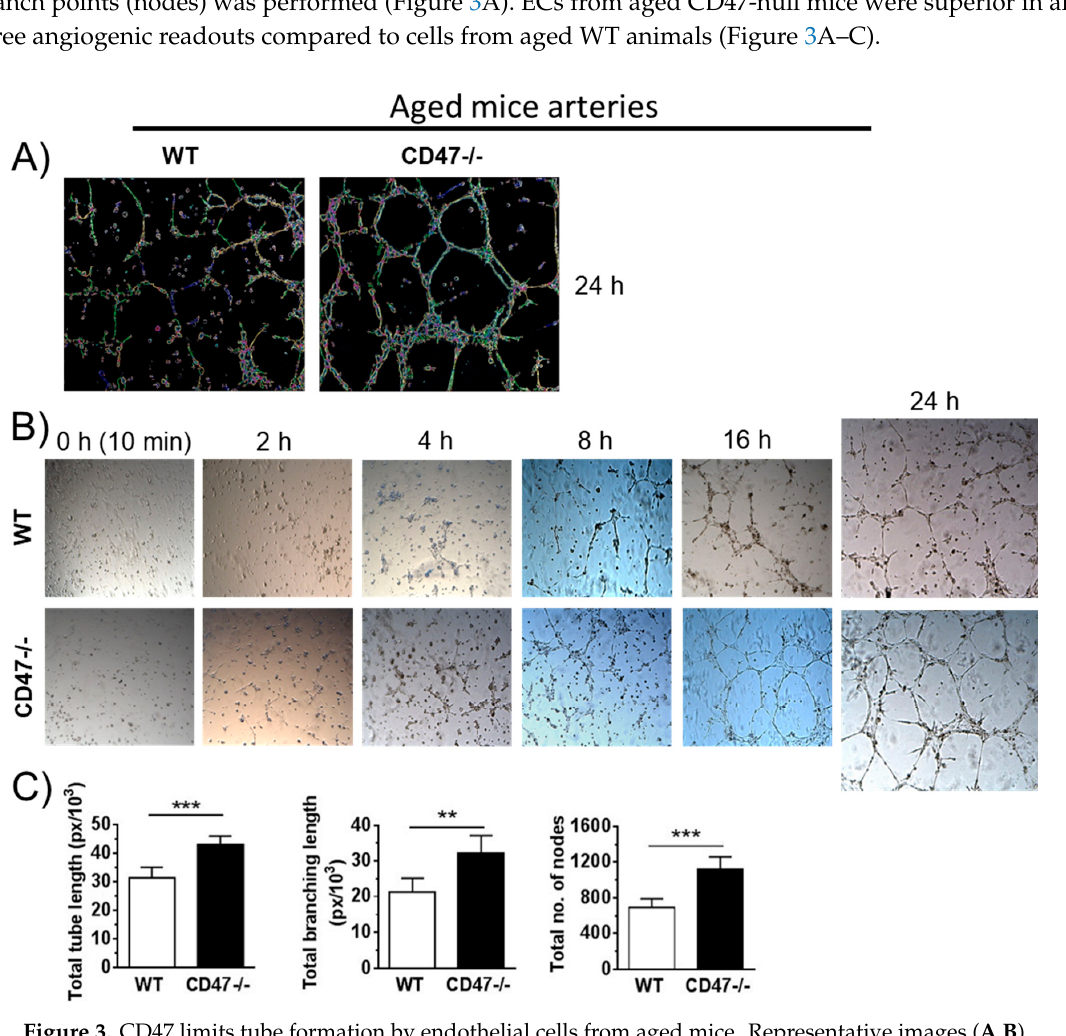
Figure 3. CD47 limits tube formation by endothelial cells from aged mice. Representative images ( A , B ) and the quantification ( C ) of total tube length, total branching length and total number of nodes of arterial ECs from aged male wild-type (WT) and CD47-null mice. Error bars represent the mean ± SEM. An unpaired t -test was performed with ** p < 0.01, *** p < 0.001.